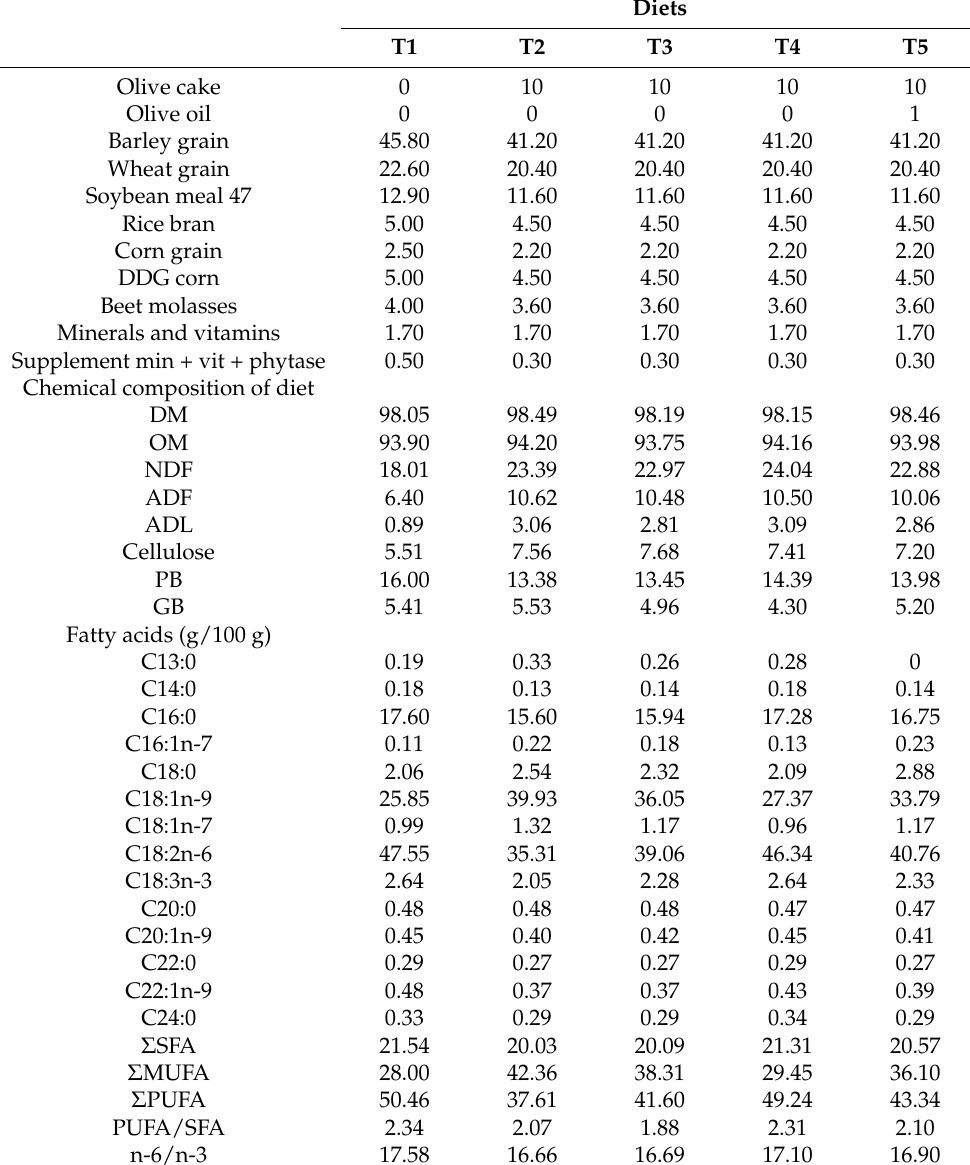
Table 1. Ingredient composition of the experimental diets (g/kg, as fed basis) and fatty acid composi- tion (g/100